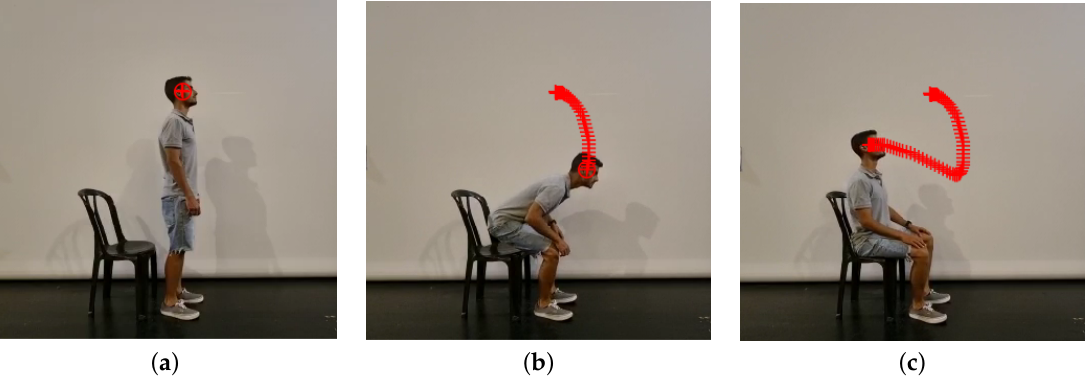
Figure 9. Process for the video analysis of a sitting man, tracking head motion: ( a ) standing; ( b ) sitting; ( c )